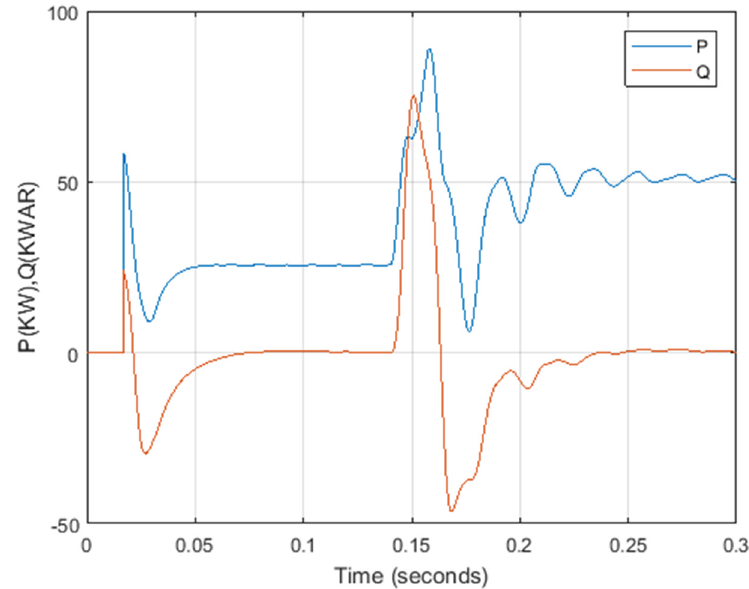
Figure 22. Active and reactive power distribution.